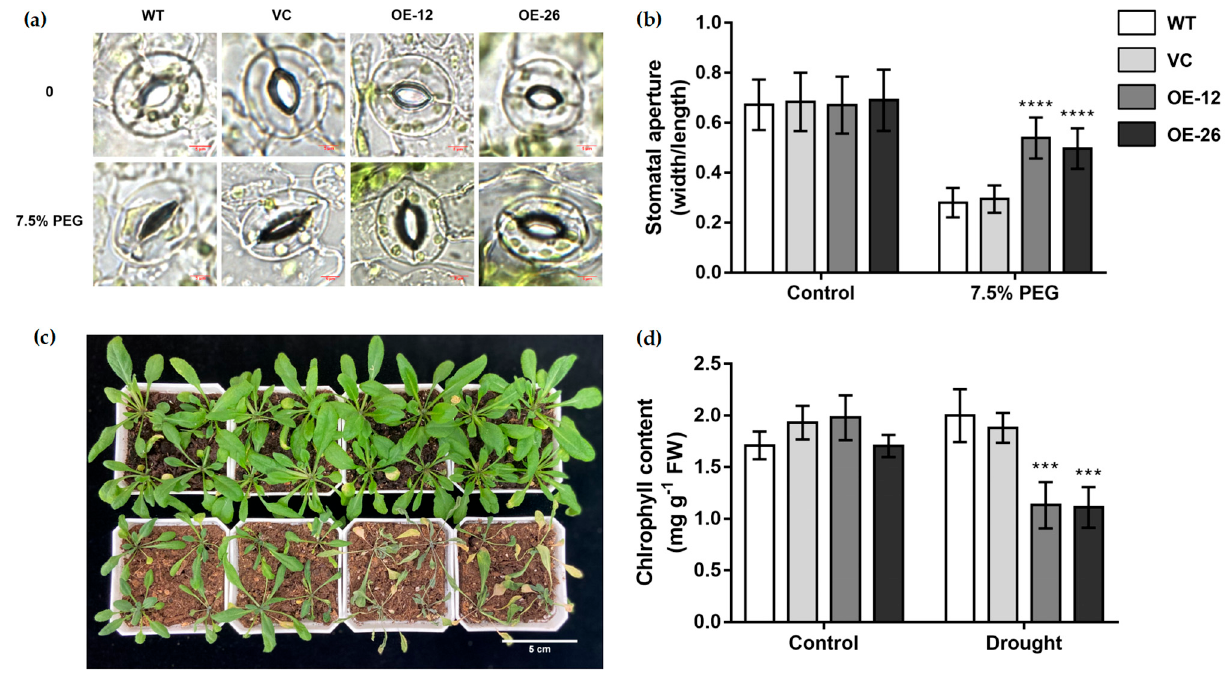
Figure 5. Phenotype of TaWRKY133 -overexpressing Arabidopsis under 10 d of drought treatment. ( a , b ) Stomatal aperture of transgenic Arabidopsis under 7.5% PEG treatment. Phenotype ( c ) and chlorophyll content ( d ) of transgenic Arabidopsis under 10 d of drought treatment. Asterisks indicate significant differences (*** p < 0.001 and **** p < 0.0001). No asterisk means non-significant difference.